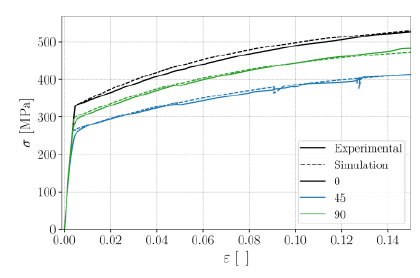
Fig. 2. Experimental and numerical stress/strain curves for three